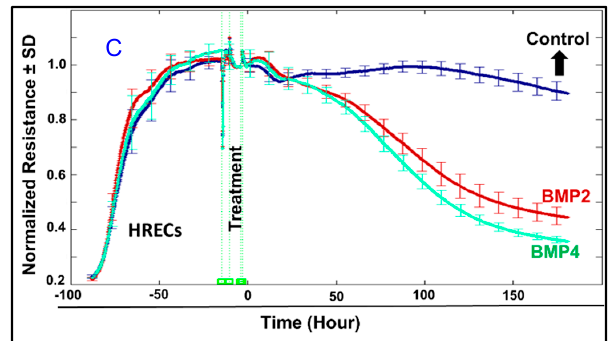
Figure 4. Normalized resistances of BMP4-treated ARPE-19 cells measured at a frequency of 4000 Hz by ECIS ( A ), and the statistical analysis ( B ). Our experiments were carried out after ARPE-19 cells formed confluent mature monolayers indicated by a plateau of electronic resistance, where the resistance reached 1000 ohms. However, to monitor changes in the resistance in real time, the data are presented as normalized TER resistance calculated by dividing the resistance of each well measured in ohms at each time point by the baseline resistance (ohms) acquired before the addition of the BMP4 and plotted as a function of time. A significant drop in the resistances of ARPE-19 cells with direct BMP4-treatment in the range of (50–400 ng/mL) over the experimental period as compared to vehicle-treated control ARPE-19 cells. Results are presented as mean ± SEM, n = 4–6/group; ** = P < 0.01; *** = P < 0.001. Black circles: control; red triangles: BMP4 (25 ng/mL); dark-red triangles: BMP4 (50 ng/mL); green triangles: BMP4 (100 ng/mL); blue triangles: BMP4 (200 ng/mL); purple triangles: BMP4 (400 ng/mL). ( C ) To ensure that the used BMP2 and 4 were active proteins, we confirmed their activity in other retinal cell-type system using human retinal endothelial cells (HRECs). As shown in the Figure, both BMP2 and 4 remarkably affected HREC’s barrier integrity. Results are presented as mean ± SEM, n = 6/group.